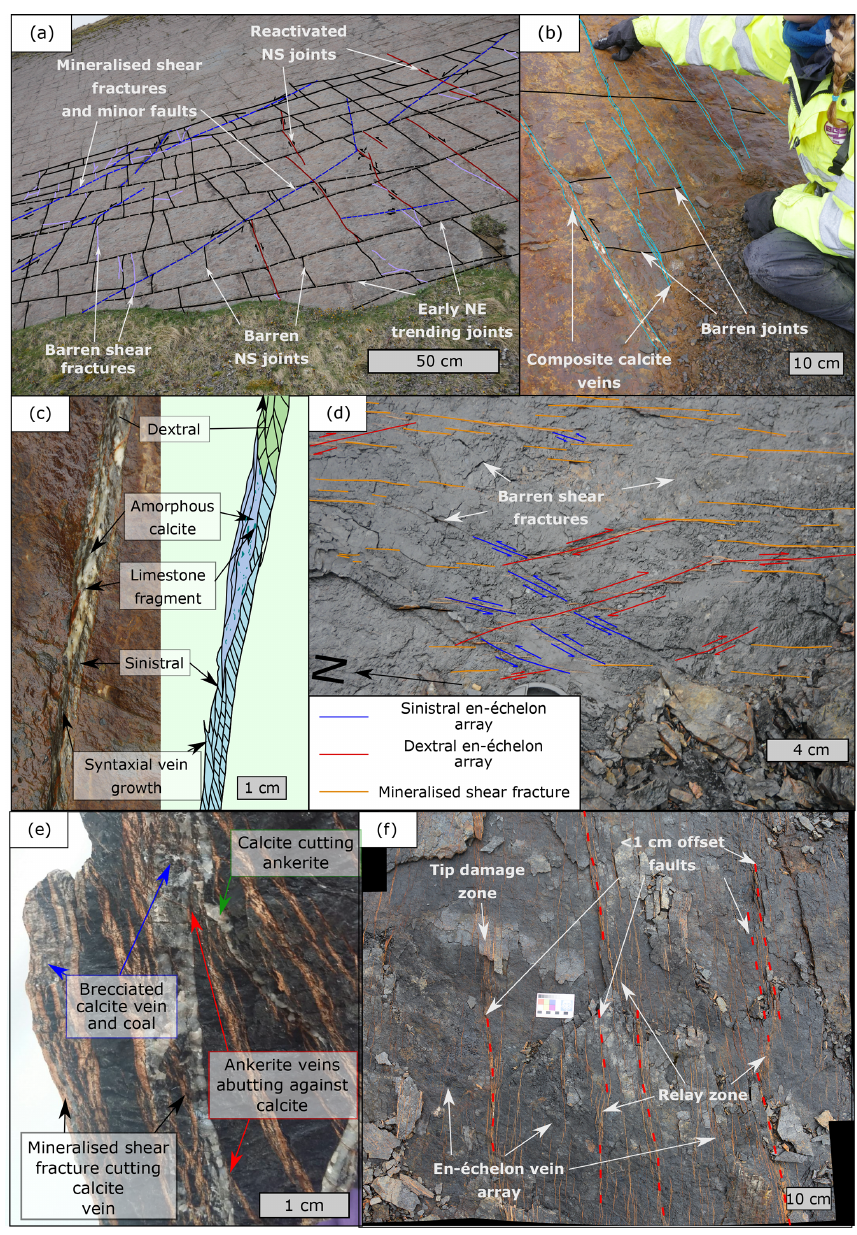
Figure 3. Typical fracture properties for McDonald Limestone and McDonald Coal: (a) joints observed away from faults across the southerly dipping (ca. 40 ◦ ) McDonald Limestone bedding plane; (b) Mineralised N–S trending calcite veins, offsetting abutting E–W ladder joints on the bedding plane of the McDonald Limestone; (c) annotated field photograph and interpretation of a multi-phase composite calcite vein exposed in the vicinity of a small stratigraphic separation fault along the McDonald Limestone Pavement; (d) bedding plane exposure of mineralised fractures present within the Muirkirk Six Foot Coal; (e) annotated hand specimen displaying the vein relationships present during the faulting of the Muirkirk Six Foot Coal; and (f) the larger-scale mineralisation pattern as you move towards small stratigraphic separation faults in the Muirkirk Six Foot